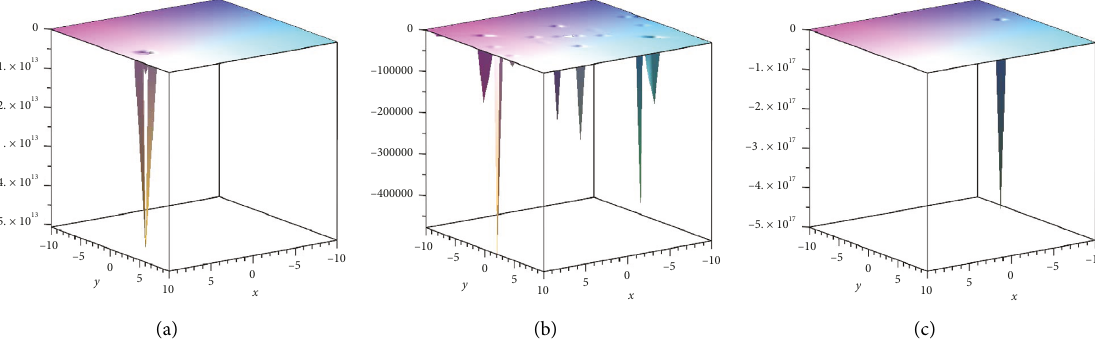
Figure 2: Evolution of equation (38) at different times. (a) Perspective view of the wave at t � − 5. (b) Perspective view of the wave at t � 0. (c) Perspective view of the wave at t �